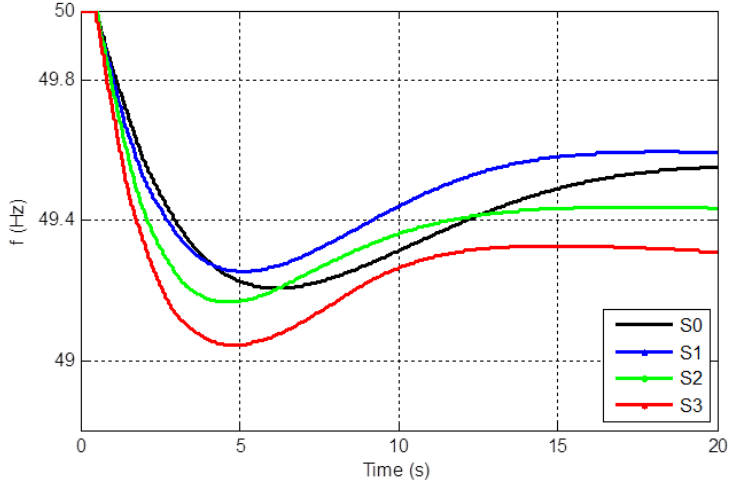
Figure 7. Frequency response with PV-PPs providing FFR, 5% deload